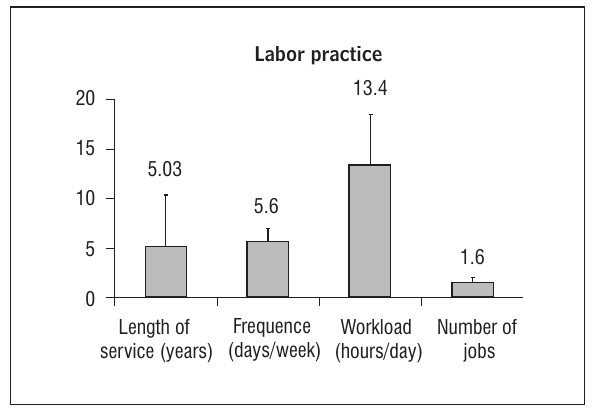
Figure 1 - Graphic representation of the mean and standard deviation of the variables related to the labor practice Source: Research